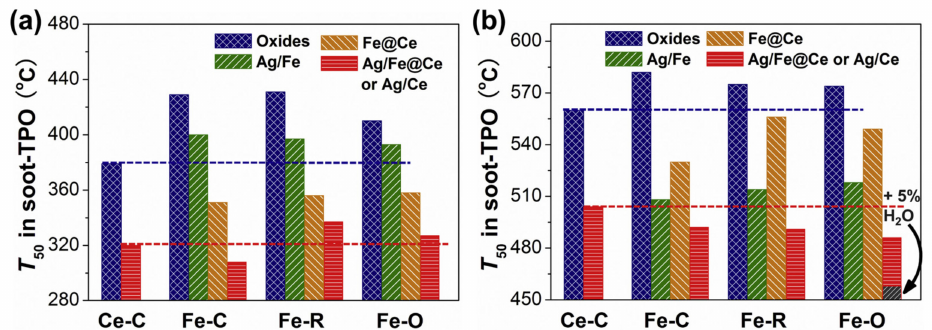
Figure 6. T 50 during TPO under ( a ) “tight” contact and ( b ) “loose” contact. Reaction conditions: 1% O 2 /N 2 (500 mL/min), heating rate = 5 ◦ C/min, and catalyst/soot = 10/1. Reproduced with permission of reference